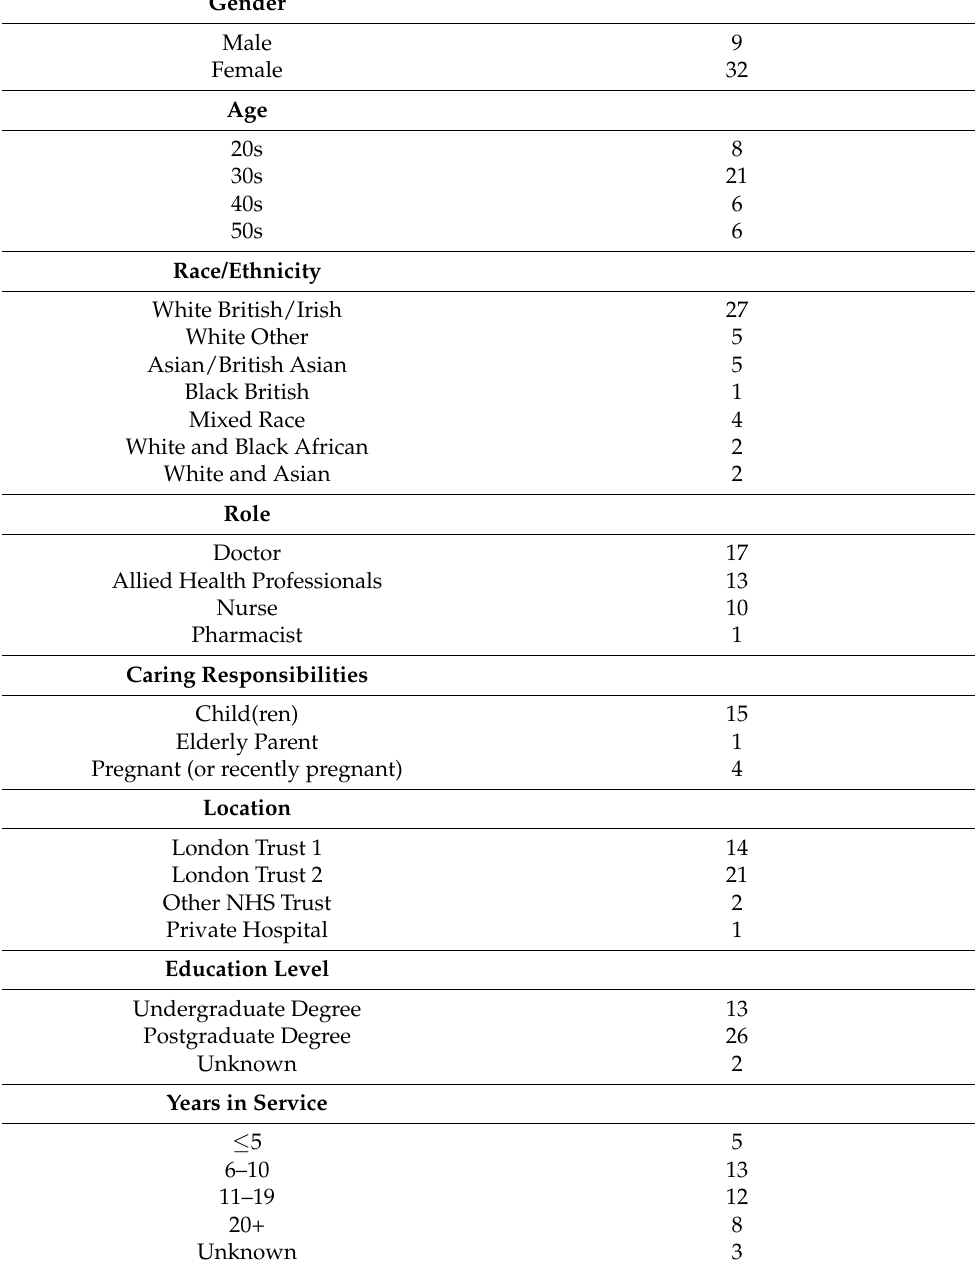
Table 1. Sample Characteristics ( n =